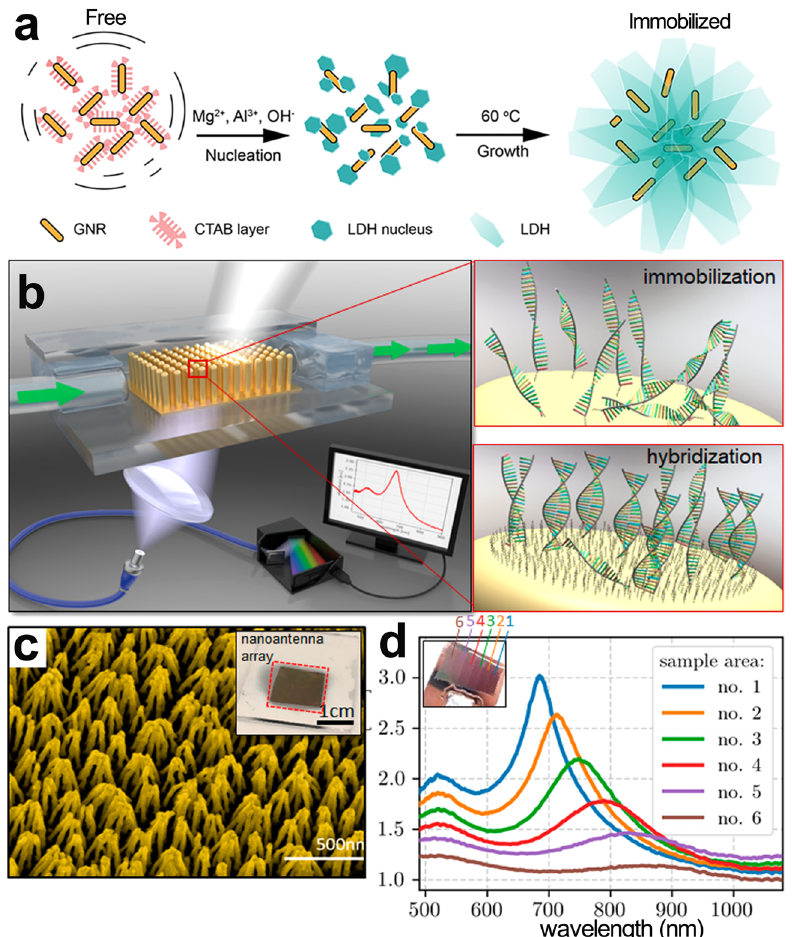
Figure 1: ( a ) Synthesis of GNR@LDH, reproduced with permission [ 78 ] . Copyright 2019, American Chemical Society. ( b ) Representative drawing of the LSPR - based biosensor for real - time detection; ( c ) SEM images of vertically aligned nanoantennas. ( d ) extinction spectra